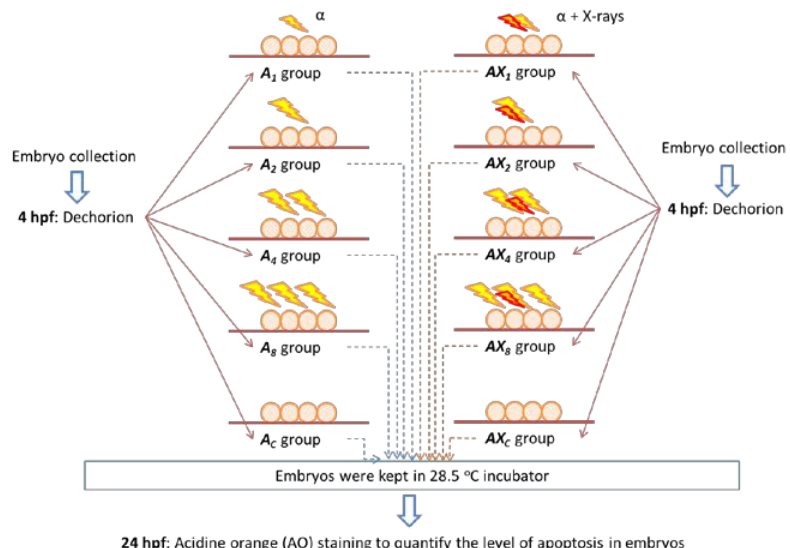
Figure 3. Schematic diagram showing the experimental steps involving embryos in the A 1 , A 2 , A 4 , A 8 , and A C groups, and AX 1 , AX 2 , AX 4 , AX 8 , and AX C